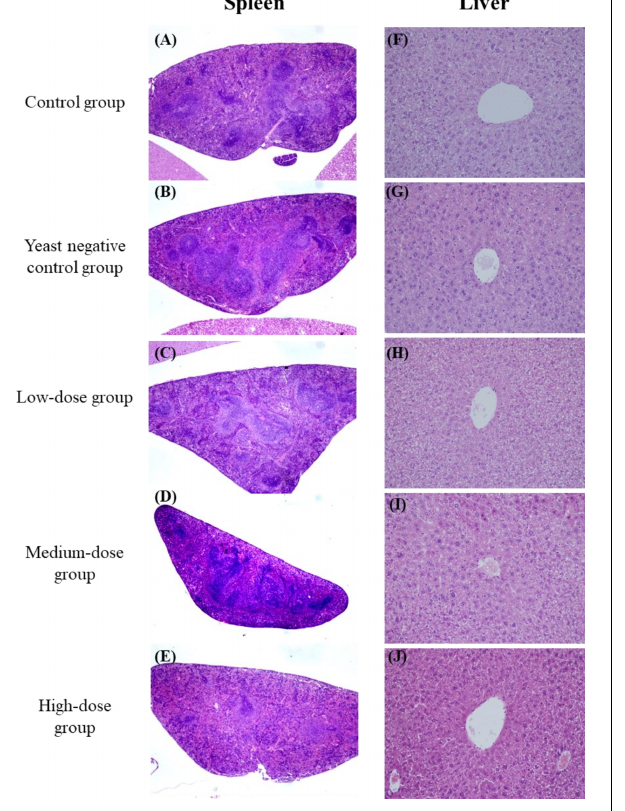
FIGURE 4 | Histopathological examination of the spleen (A–E) and liver (F–J) from immunized mice. Tissues were collected and stained with hematoxylin and eosin (H&E; original magnification 10 ×